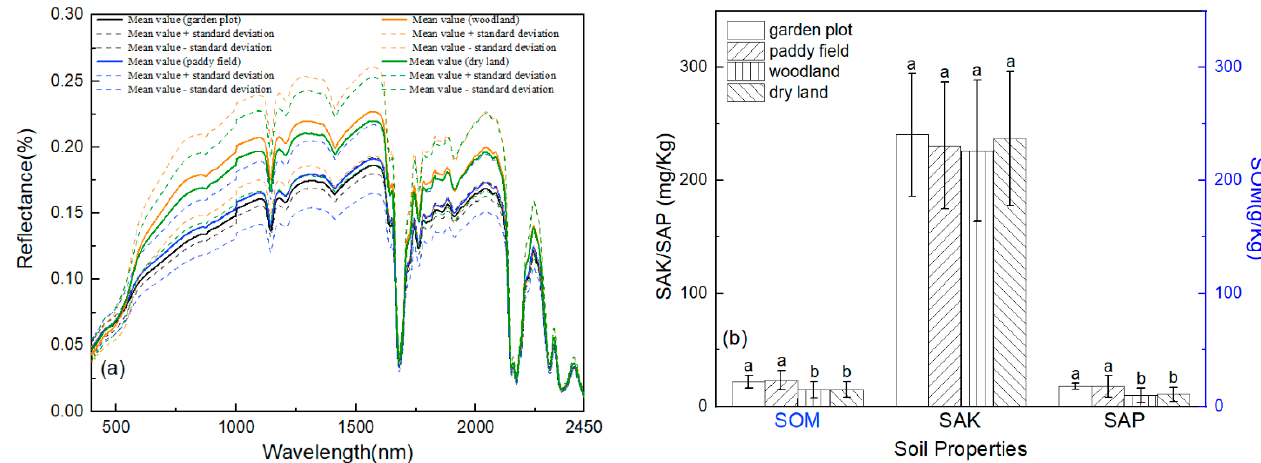
Figure 3. Soil nutrients, mean value, and standard deviation of the spectrum relative to land use ( a ). Letters on top of each box indicate statistical similarity (boxes with similar letters) or dissimilarity (boxes with dissimilar letters) between land use systems ( p < 0.05) ( b ).